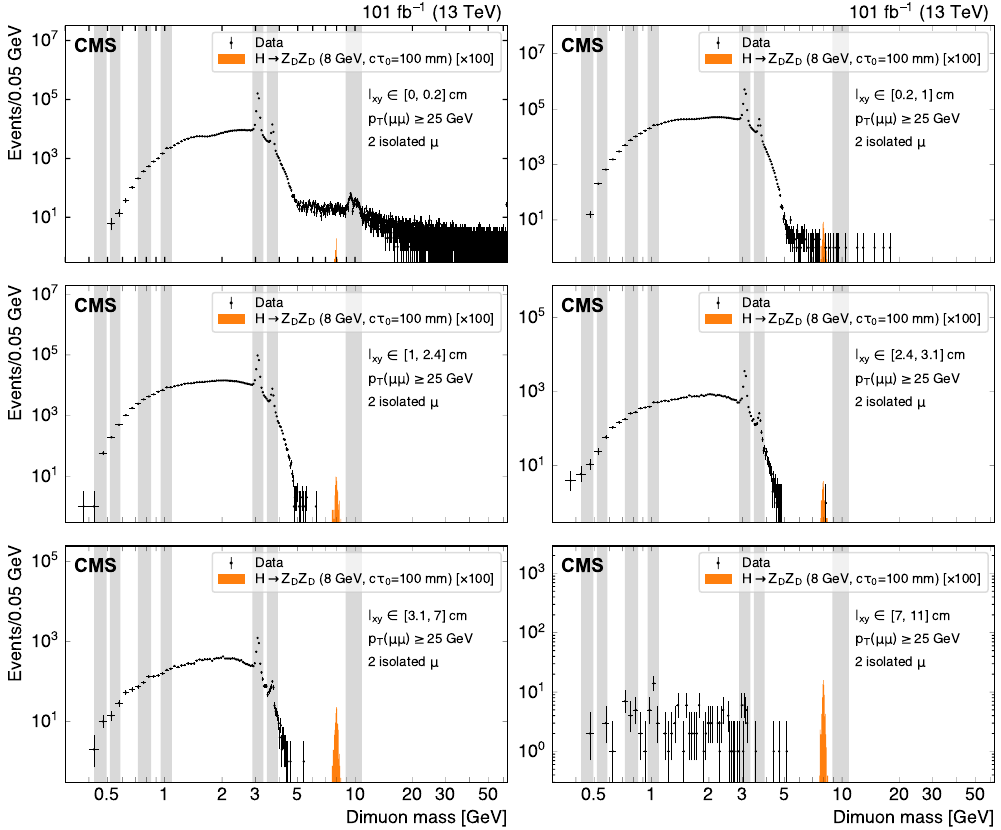
as obtained from xy ≥ 25 GeV: (upper left) T < 1 . 0 cm; (middle left) 1 . 0 ≤ l < 2 . 4 cm; (middle xy xy < 7 . 0 cm; (lower right) 7 . 0 ≤ l < 11 . 0 cm. xy xy Z signal model with m = 8 GeV and Z D D D Z ) B (Z → mm ) = 1 . 2 × 10 − 5 , equal to the D D D